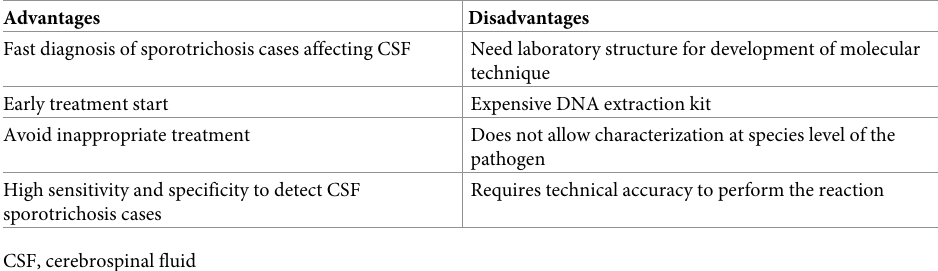
Table 1. Advantages and